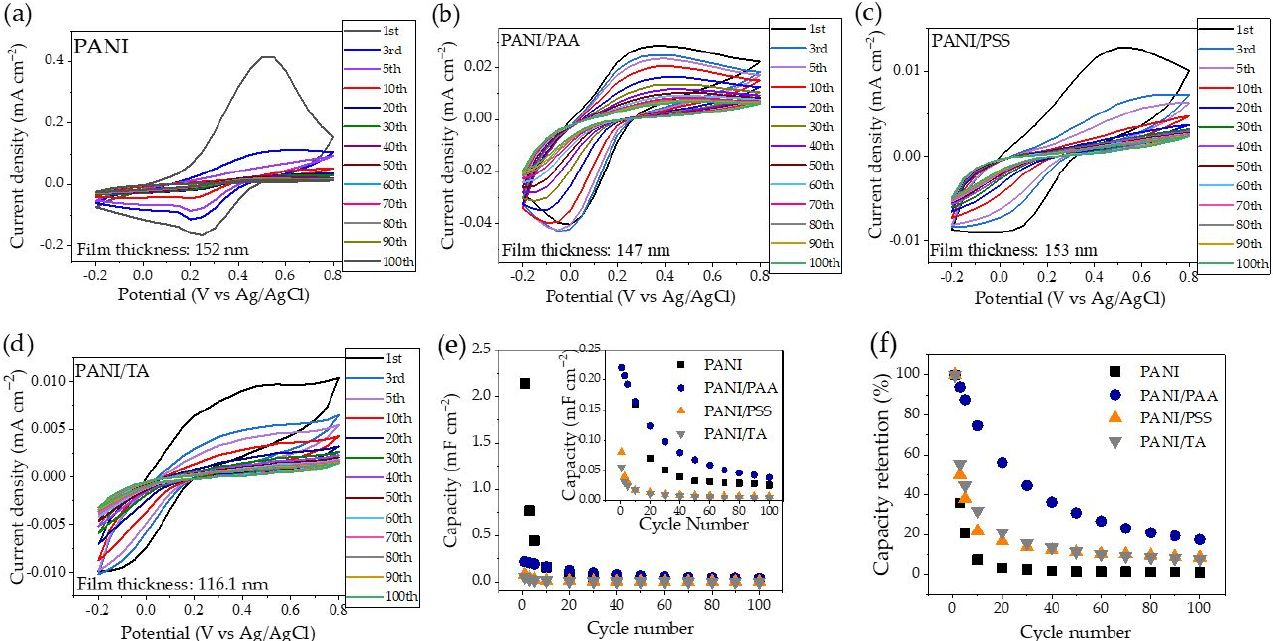
Figure 7. The cyclic voltammograms of ( a ) PANI, ( b ) PANI/PAA, ( c ) PANI/PSS, and ( d ) PANI/TA at the scan rate of 50 mV/s, and ( e ) a plot of areal capacitance, and ( f ) capacitance retention vs. cycle numbers.